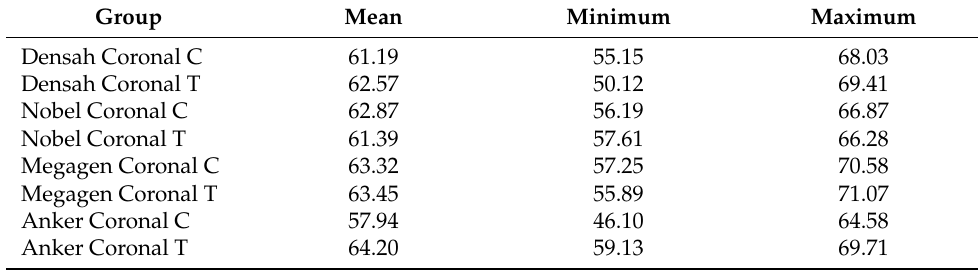
Figure 6. Figure composition showing representative samples of 2D sections at the coronal region for clockwise and counterclockwise drilling for all of the drill designs. Clockwise and counterclockwise drilling produced microfractures of the implant bed walls. Some localized thickening was observed in both drilling directions. However, wall density was not increased in any of the drilling directions. Table 2. Descriptive statistics. Relative bone condensation at the coronal